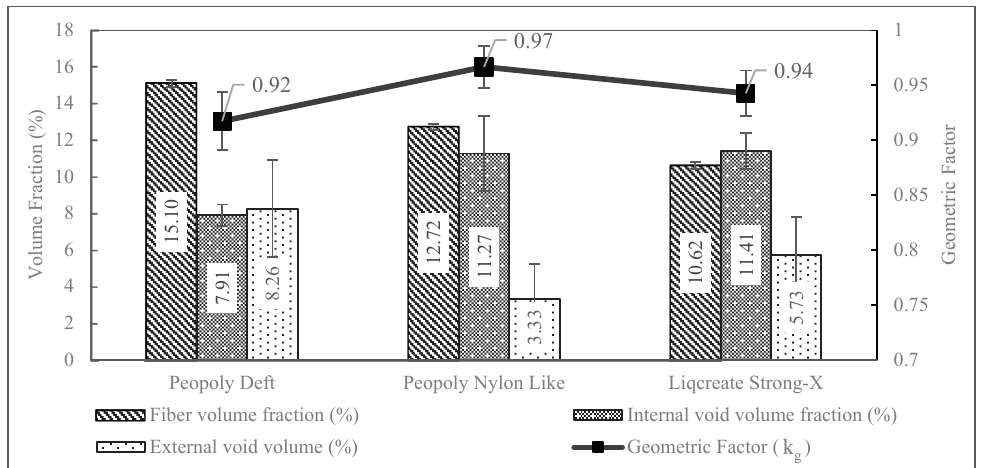
Figure 5. Composition of 3D-printed composite bars.